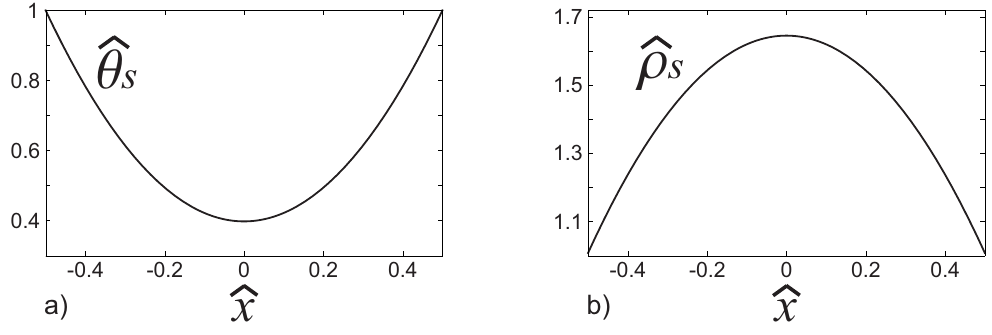
Figure 1. Dimensionless RBCs temperature ( a ) and dimensionless RBCs density ( b ) obtained in terms of ˆ x with ε s = 0.24.